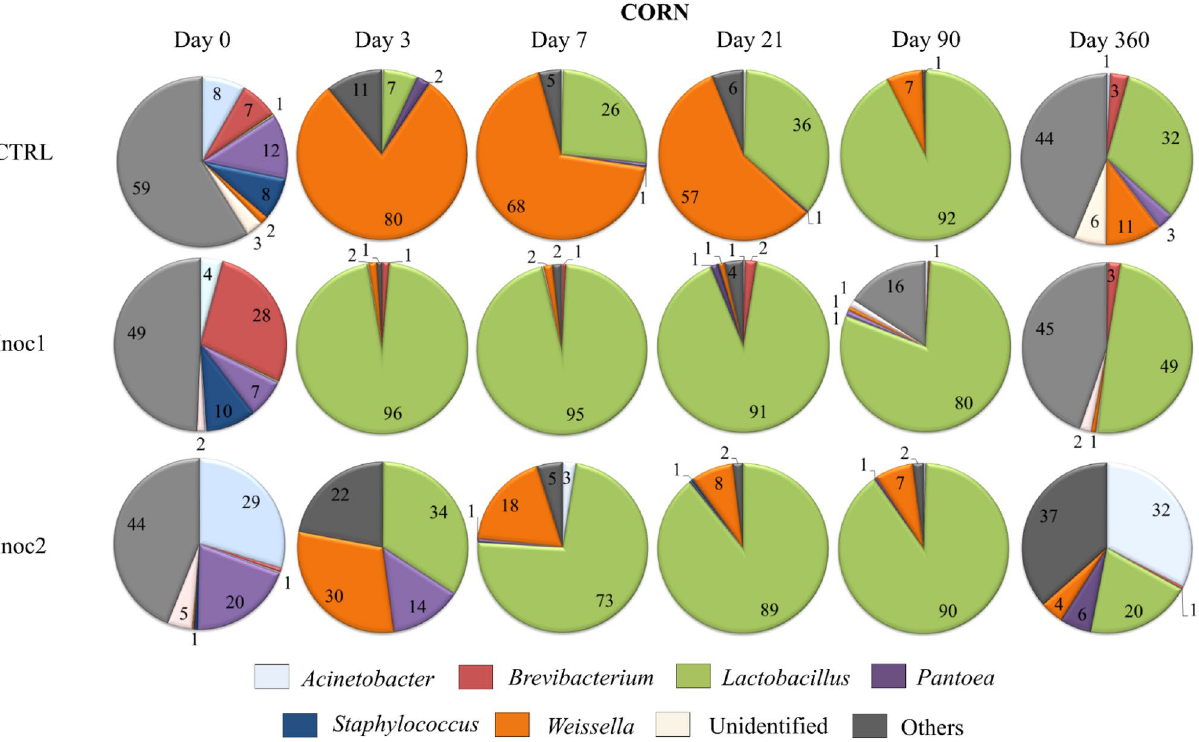
Figure 3. Main genera dynamics (%) of bacterial communities of rehydrated corn grain silages after 0, 3, 7, 21, 90 and 360 days of fermentation. CTRL non-inoculated, Inoc1 Lactobacillus plantarum and Propionibacterium acidipropionici , Inoc2 Lactobacillus buchneri .